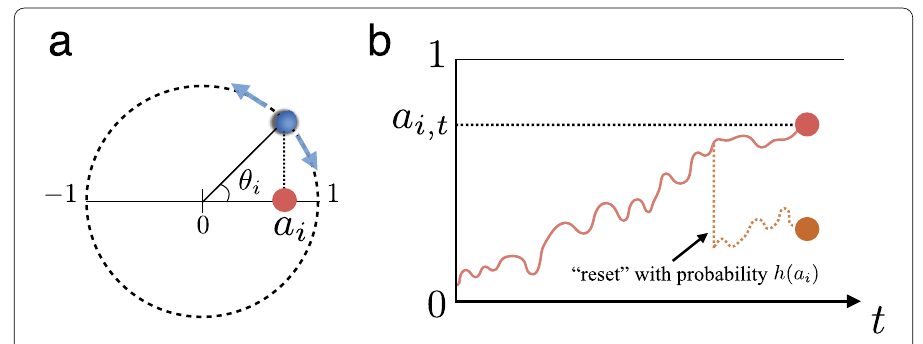
Figure 4 Schematic of the activity update in the dynamical fitness model. ( a ) Circular random walk of angle